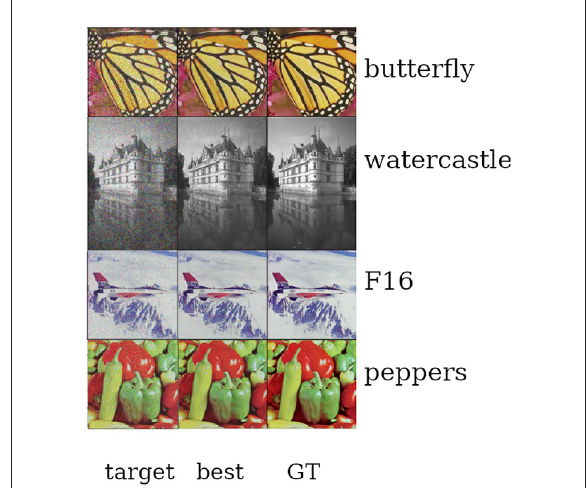
FIGURE1 The four images analyzed. Image with noise (target, on the left), what is achieved from the CNN (best, center), and what is the unknown ground-truth (GT, on the right).